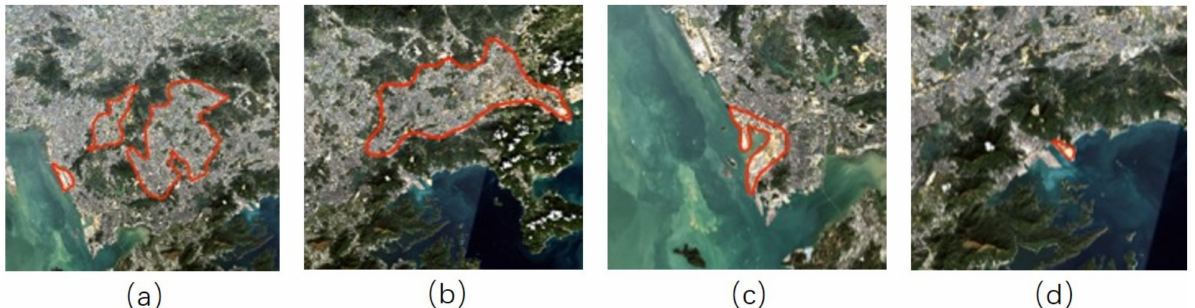
Figure 8. The increase in impervious surface areas of Hong Kong: ( a ) Pillar Point; ( b ) Hong Kong Disneyland Resort; ( c ) the Hong Kong-Zhuhai-Macau Bridge.